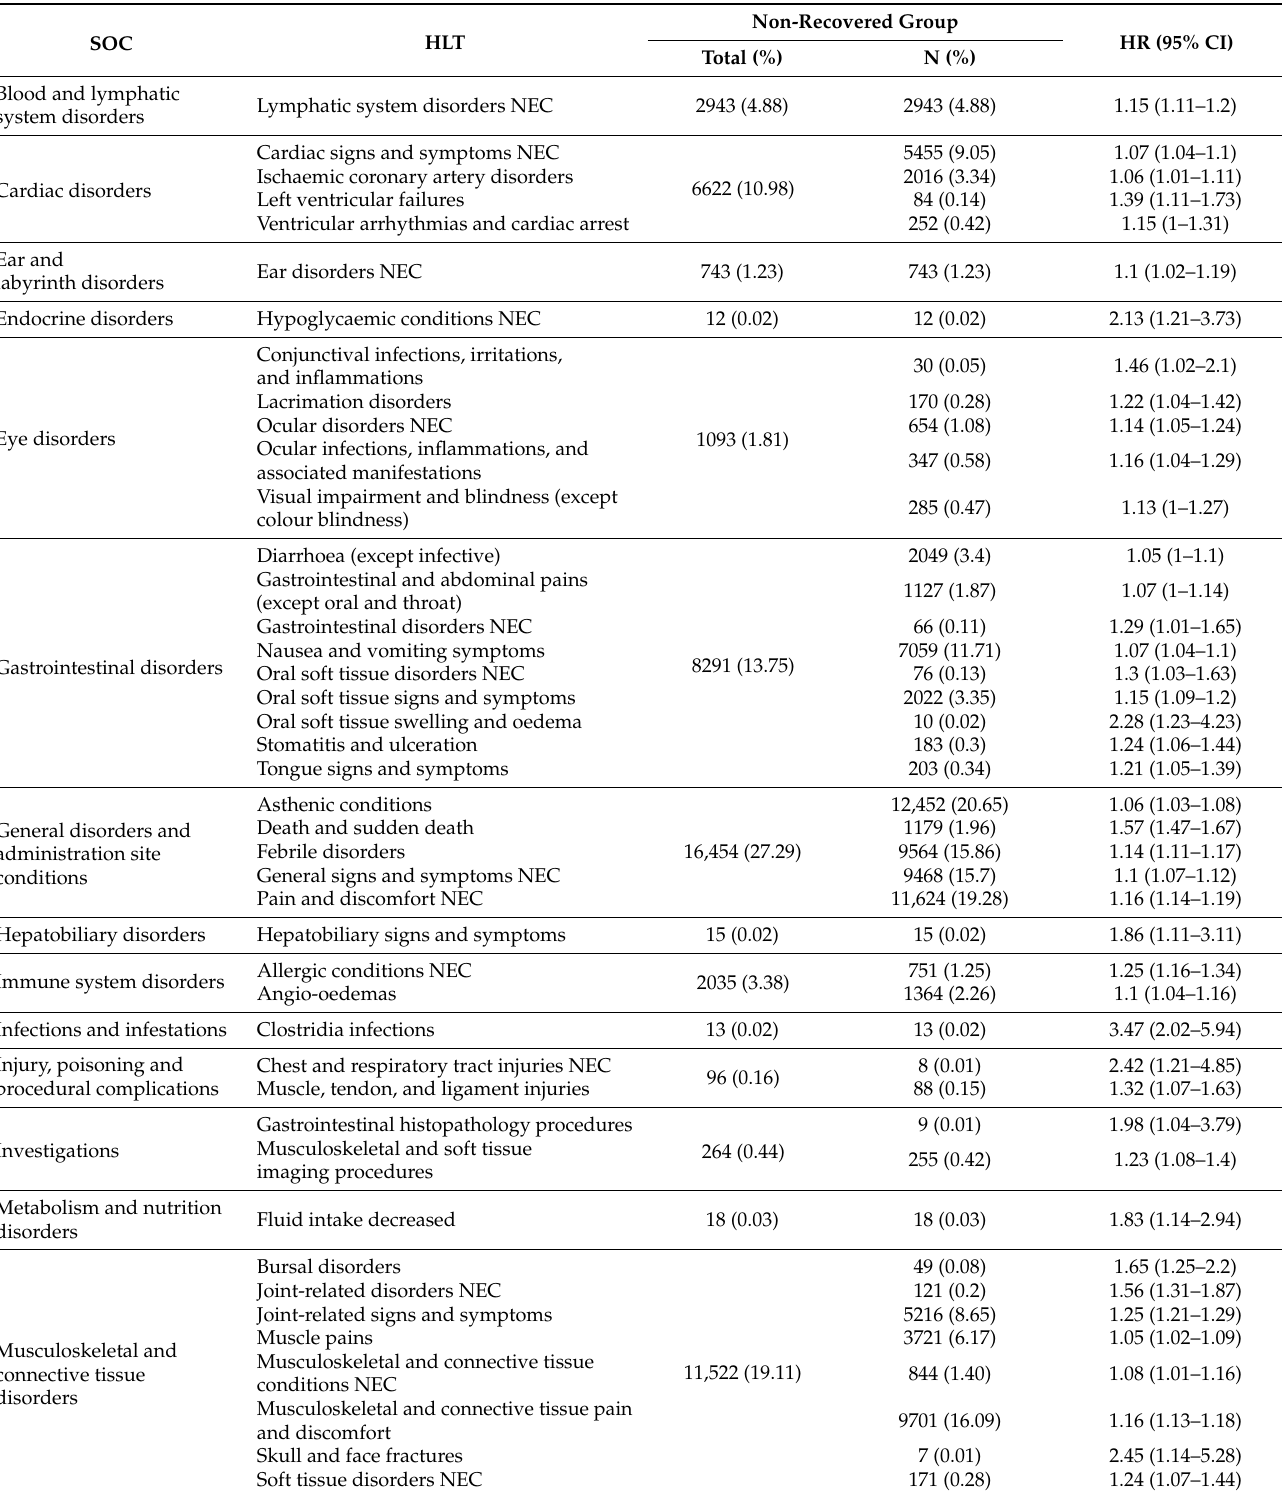
Table 3. AEFIs related to delayed recovery after receiving the Moderna COVID-19